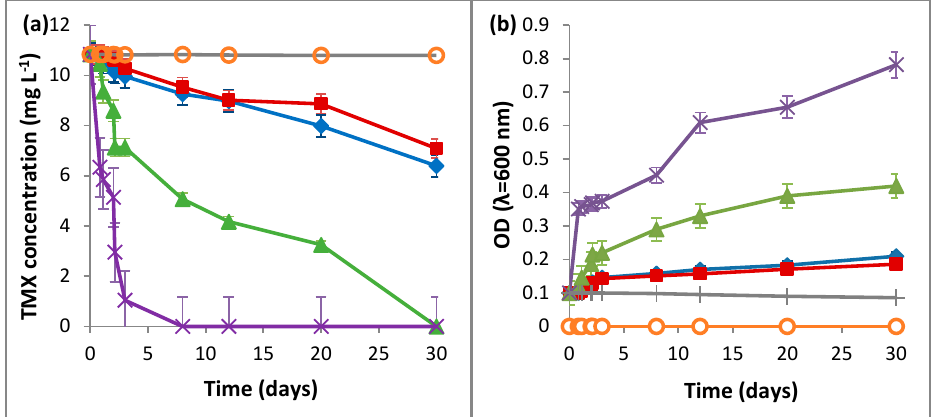
Figure 1. Use of TMX by L. portucalensis F11 at a concentration 10.8 mg L − 1 during 30 days of incubation, as ( ♦ ) the sole carbon and nitrogen source; ( ■ ) the sole carbon and sulfur source; ( ▲ ) the sole carbon source; ( × ) periodic feeding with 5.9 mM of sodium acetate; abiotic ( ○ ) and adsorption (+) controls. ( a ) TMX degradation and ( b ) cellular growth. Error bars present means of three replicates ± standard deviation.